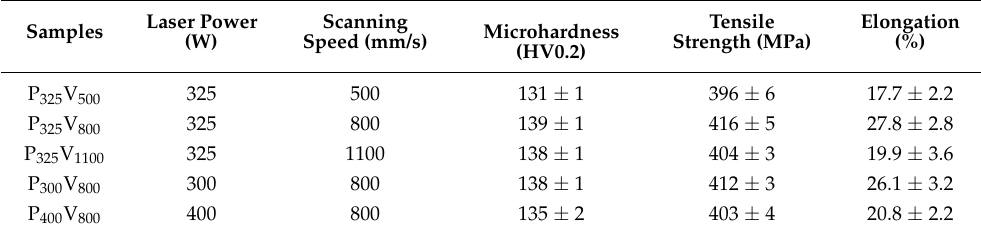
Figure 17. The stress-strain curve of Cu–Cr–Nb–Ti alloys manufactured using different process parameters. Table 4. Mechanical properties of as-built Cu–Cr–Nb–Ti alloys manufactured using different process parameters.